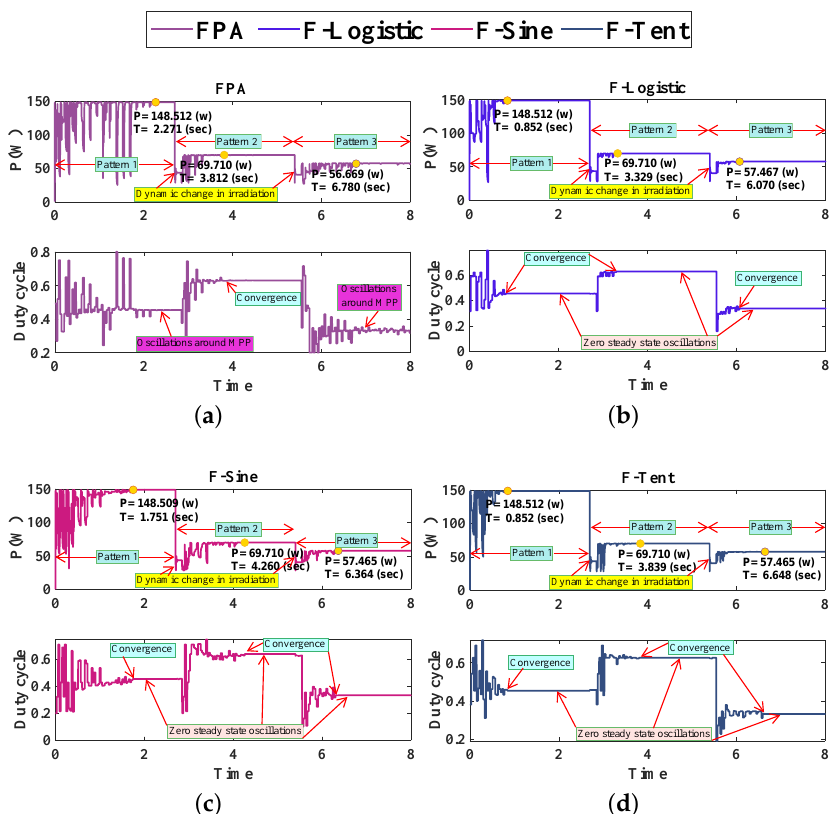
Figure 6. The obtained power and duty cycle by the algorithms over the step changes in irradiance condition from pattern 1 to 2 to 3 in the case of 4S of S36 connected PV array: ( a ) FPA, ( b ) F-logistic map with FPA, ( c ) F-sine map with FPA, and ( d ) F-tent map with